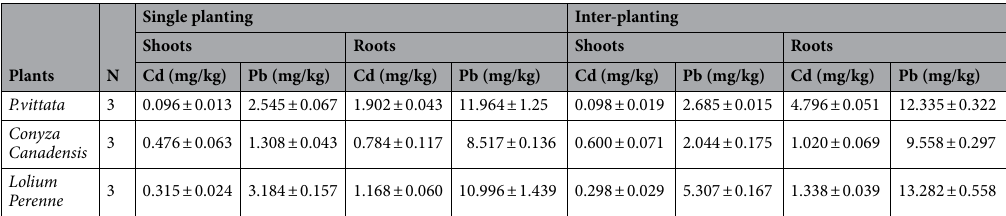
Table 2. Mean values for cadmium and lead content comparisons in single planting and interplanting with garlic. N number of plants sampled.